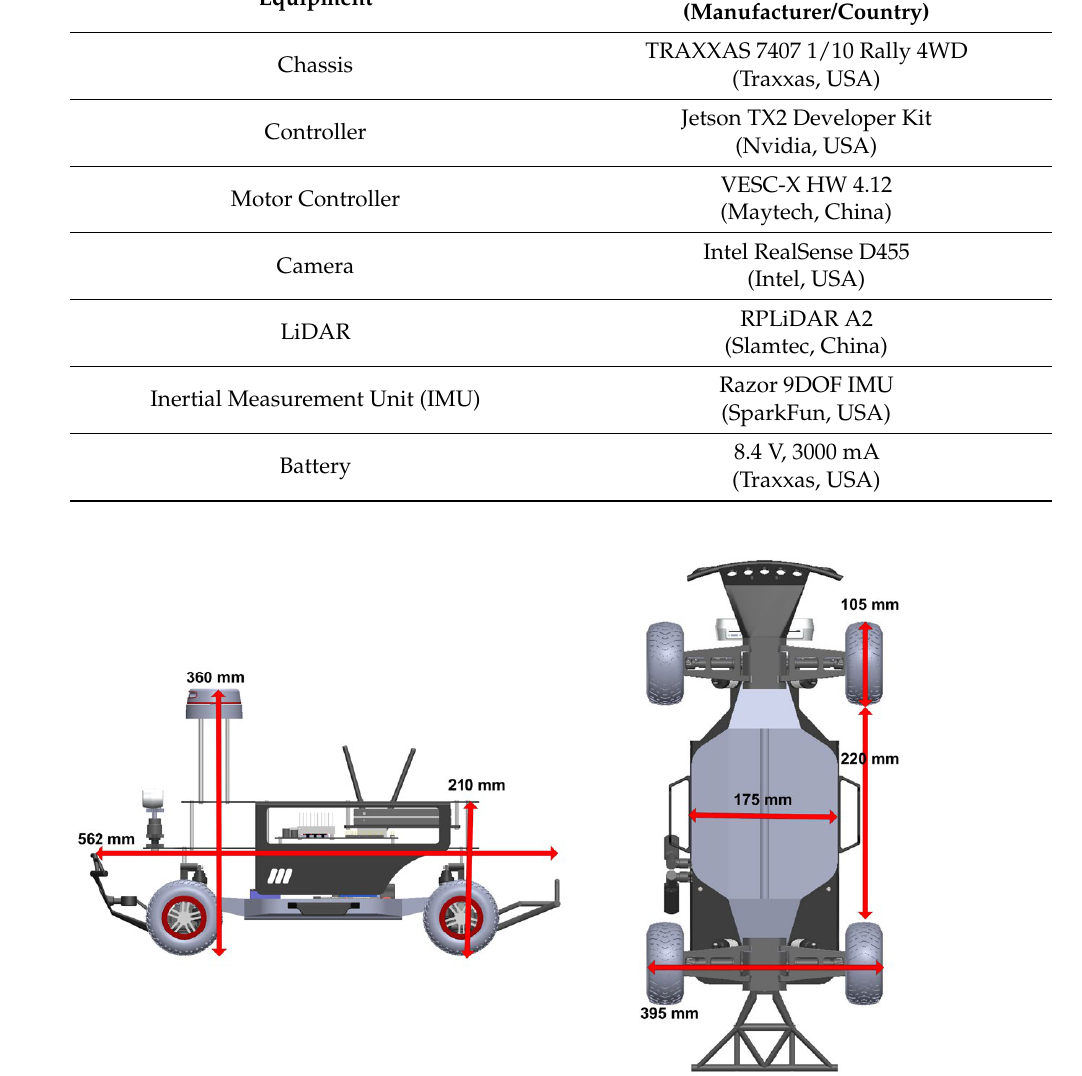
Figure 4. Frame size of the autonomous mobile robot.